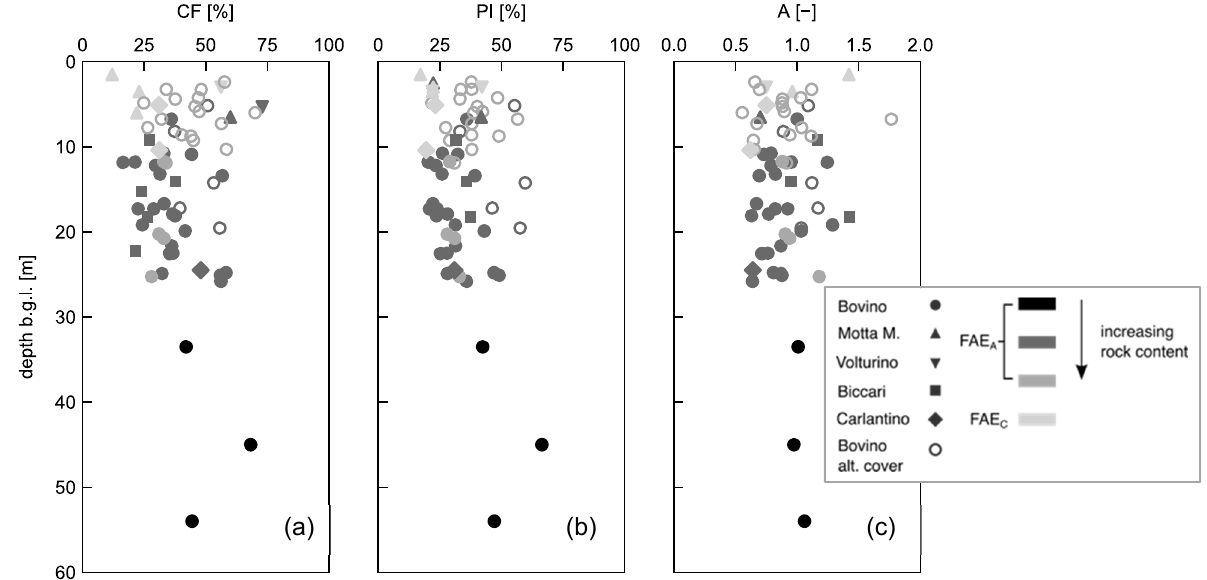
Figure 15. Index properties of Faeto Flysch: clay fraction ( a ); plasticity index ( b ); activity ( c ).